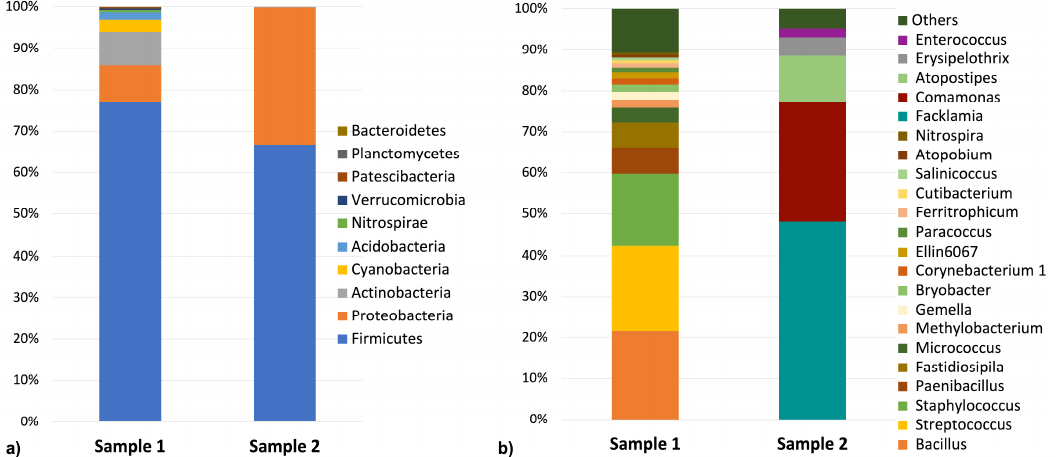
Figure 6. Metagenomic data of rock samples to ( a ) Phylum level; ( b ) Genus level with a relative abundance of higher than 1% in the samples.